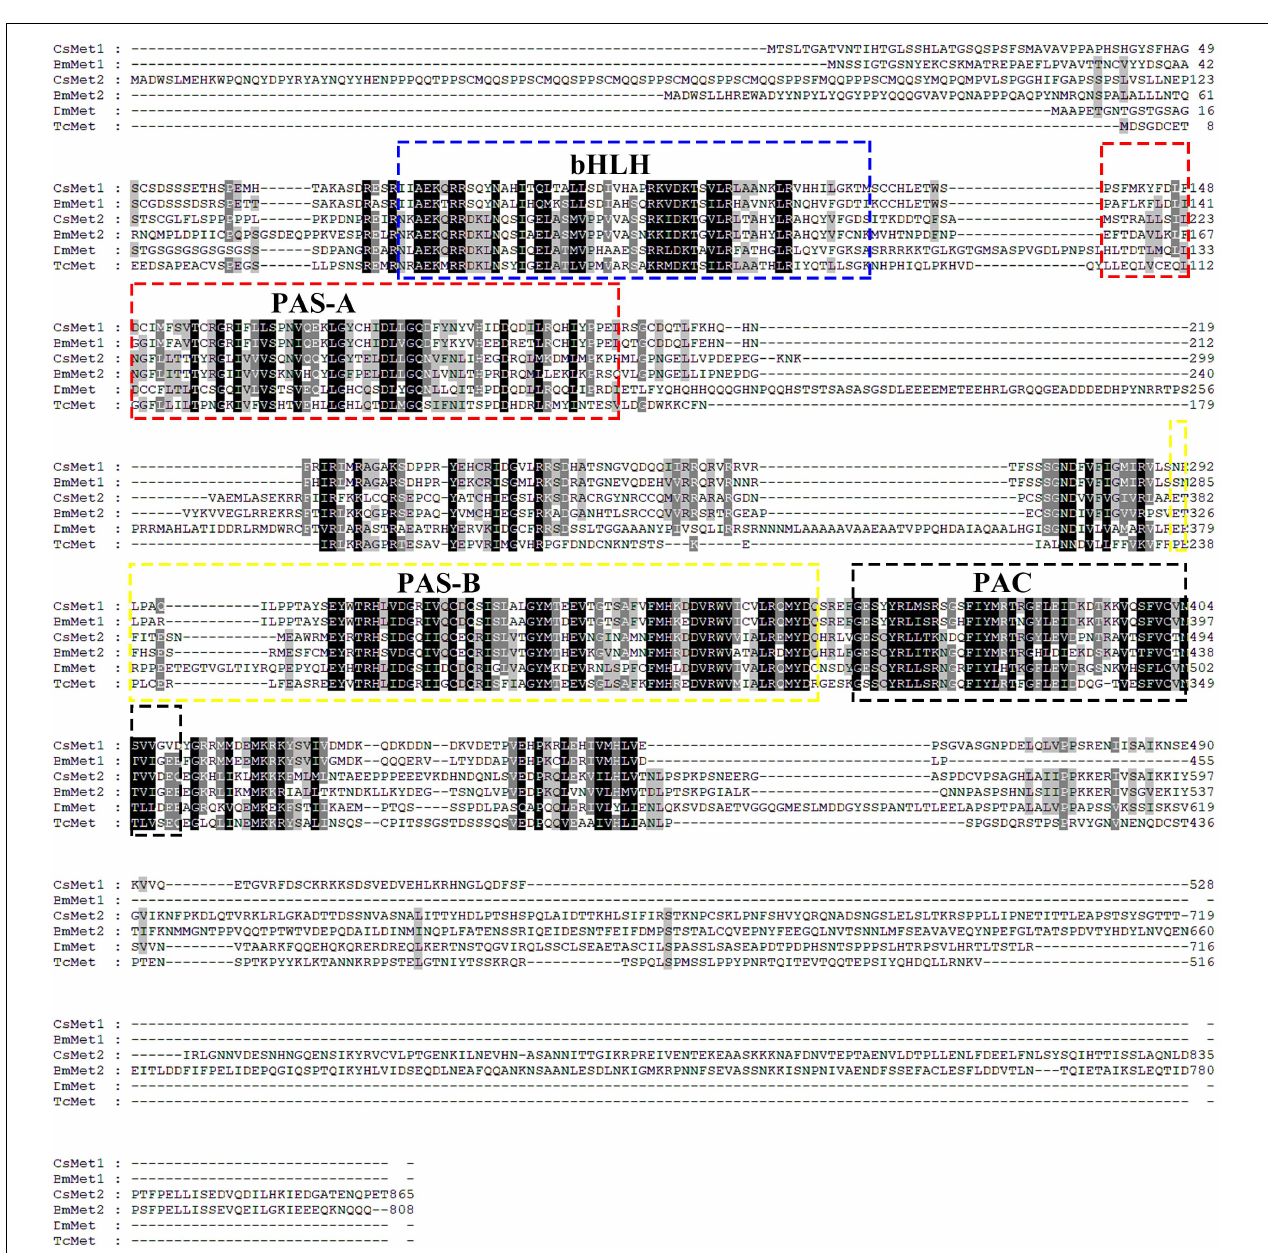
FIGURE 1 | Amino acid sequence alignments of CsMet1 , CsMet2 and other representative insect Mets. Met sequences were obtained from the following GenBank entries: NP001108458 for B. mori BmMet1 , BAJ05086 for B. mori BmMet2 , AAC14350 for D. melanogaster DmMet and NP 001092812 for T. castaneum TcMet .